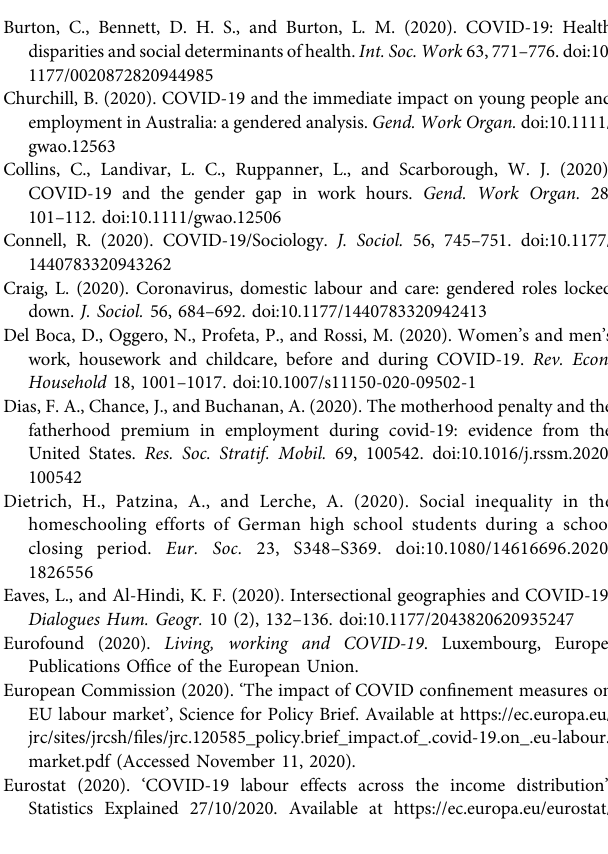
Frontiers in Sociology |